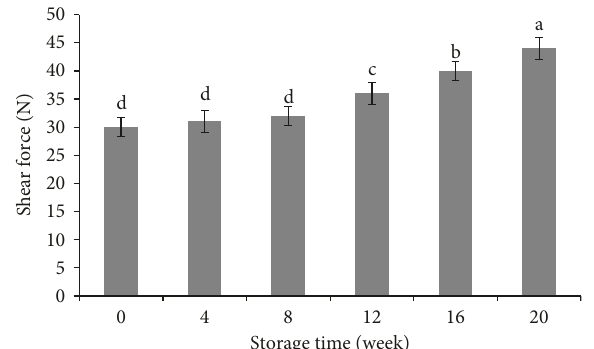
Figure 7: Changes in shear force of the Basa fish fillet during frozen storage at − 20 ° C for 20 weeks. Bars represent standard deviation from six determinations. The different letters on the bars indicate significant differences ( p < 0 .